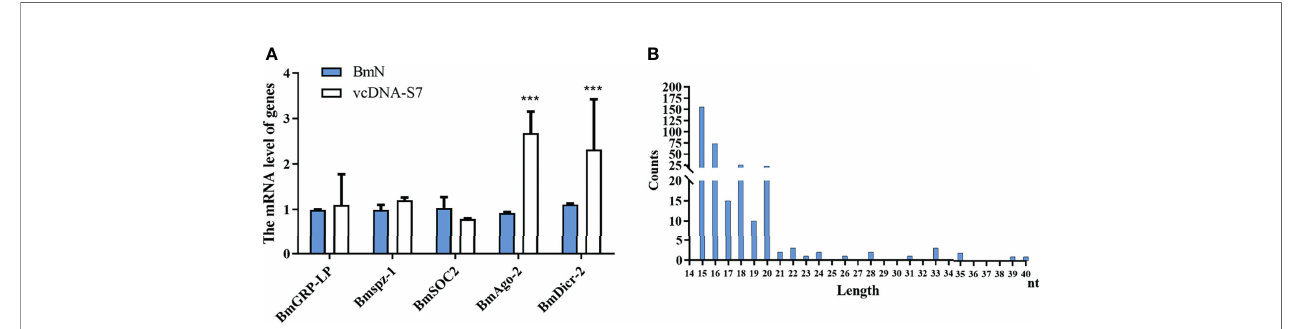
FIGURE 7 | vcDNA-S7 can provide vsiRNAs for RNAi pathway. (A) Effects of vcDNA-S7 on the main immune pathways of mori . BmN cells (1×10 6 ) were transfected with 1 m g vcDNA-S7 for 48 h. The relative RNA level of the key genes in the immune pathways (including RNAi, JAK-STAT, Imd, and Toll pathway) was determined by real-time PCR (n=2, *** P <0.001). (B) 1×10 7 BmN cells were transfected with 6 m g vcDNA-S7 for 48 h and small RNAs were deep sequenced. Size distribution of vsiRNAs derived from vcDNA-S7